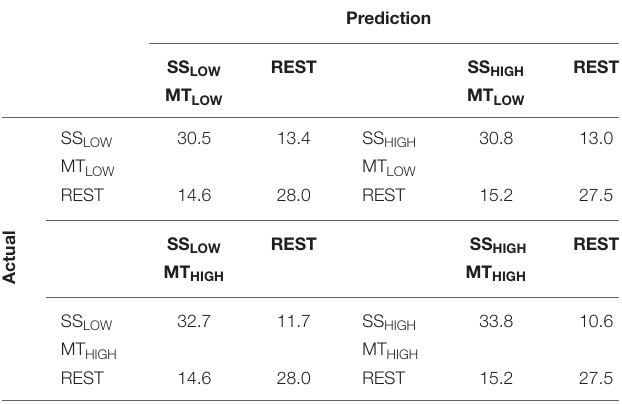
TABLE 6 | Confusion matrices summarizing the classification performance of the cross-classifiers (CC) using alpha band features, trained on SS and tested with MT averaged over all subjects ( n =